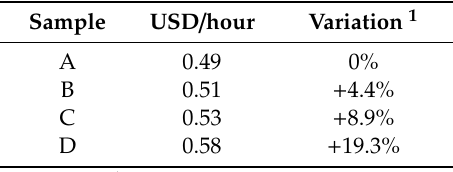
Table 6. Willingness to accept compensation results.